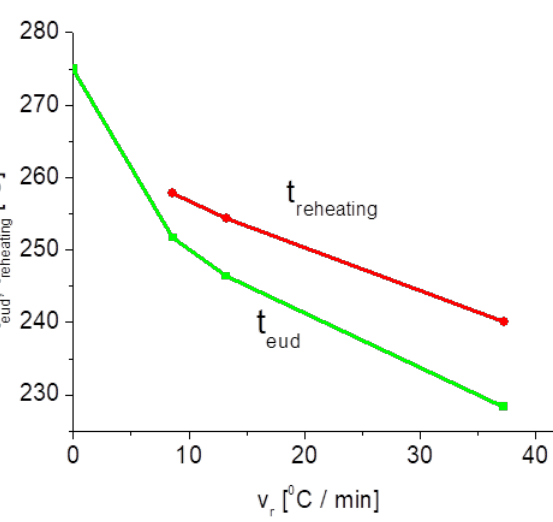
Figure 12. Variation of the eutectoid and recoalescence transformation temperatures as a function of the un-controlled cooling rate applied during DIL analysis for the gravity casted ZnAl22 alloy (in steel die).